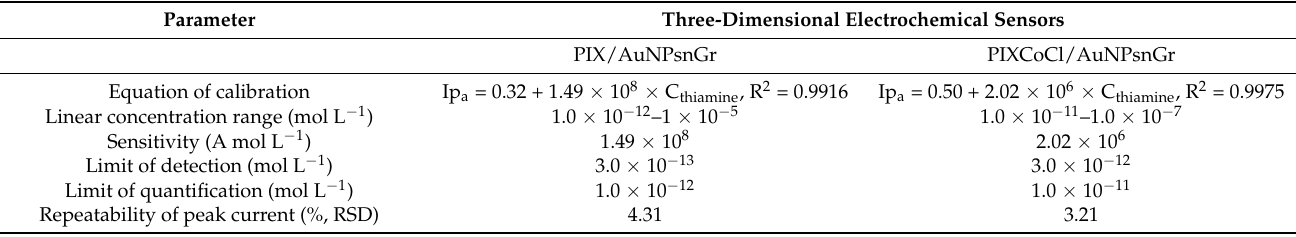
Table 1. Response characteristics of the 3D electrochemical sensors used for detection of